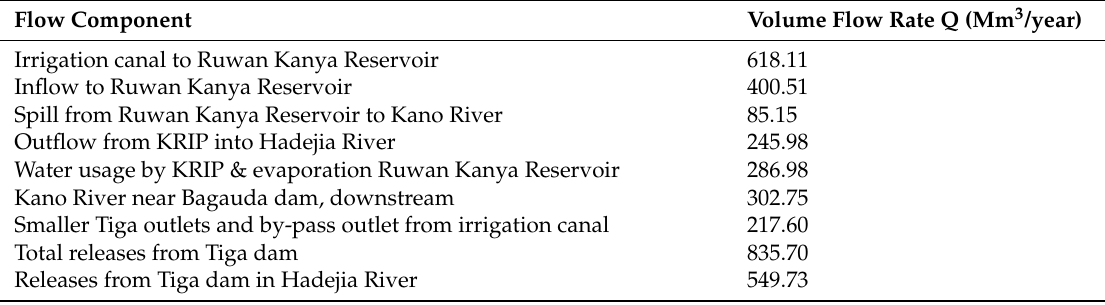
Table 1. Dry-season flows in the Hadejia River (February–March